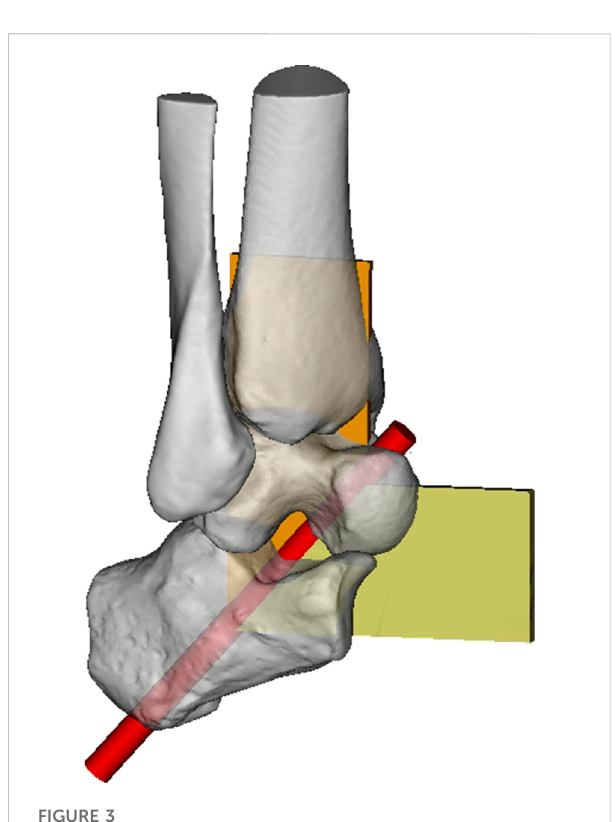
FIGURE 3 Concept of the subtalar joint as mitred